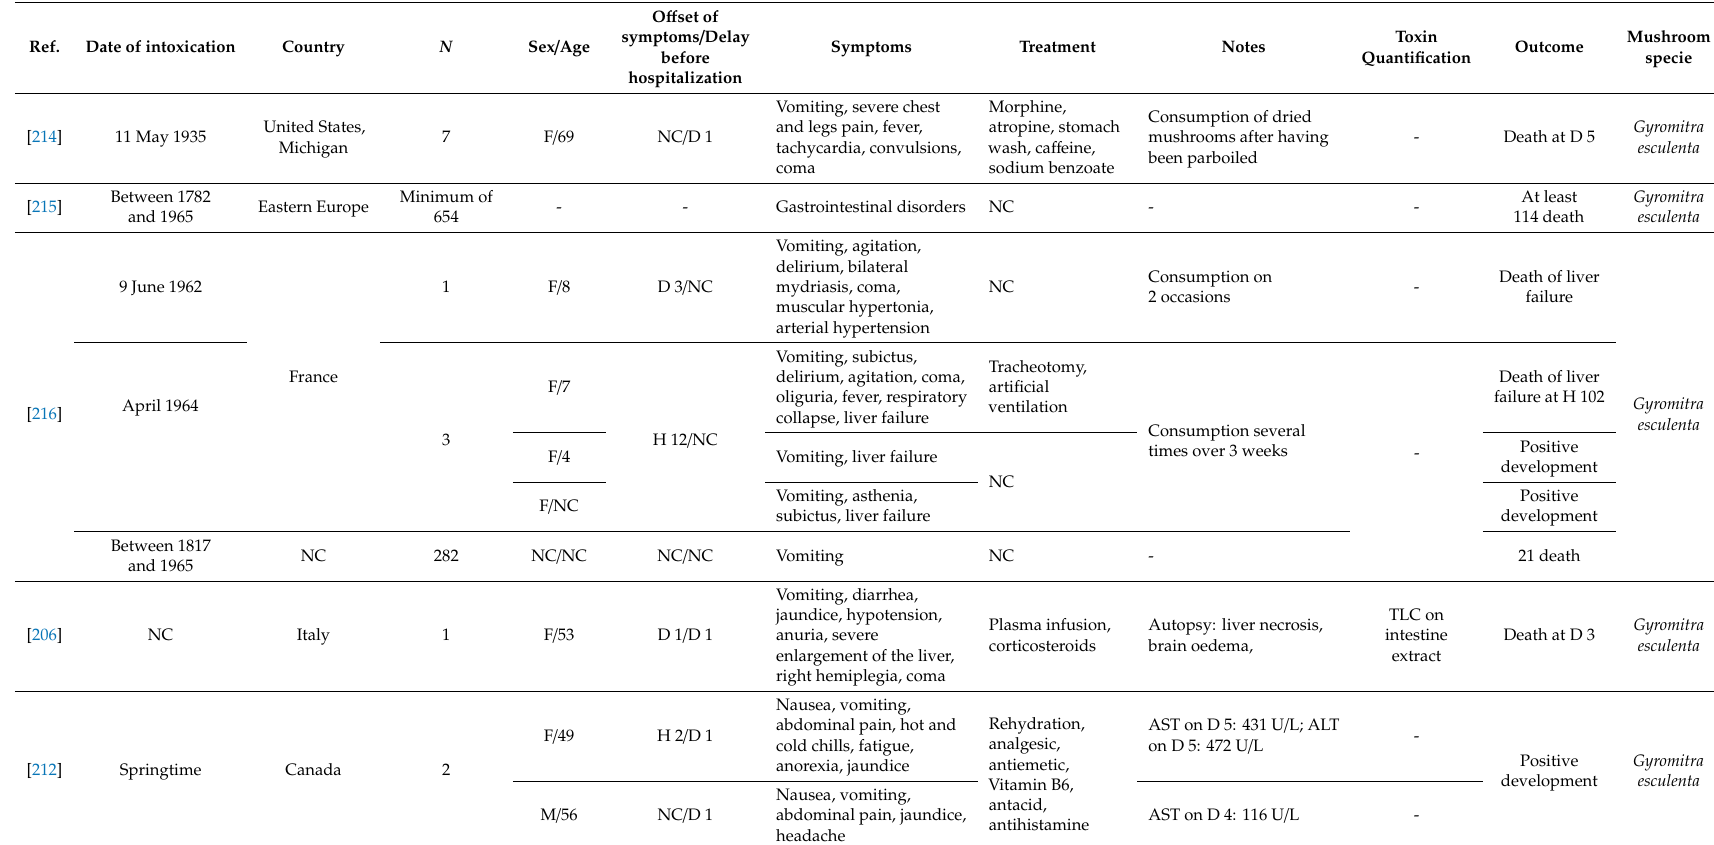
Table 8. Cases of gyromitrine